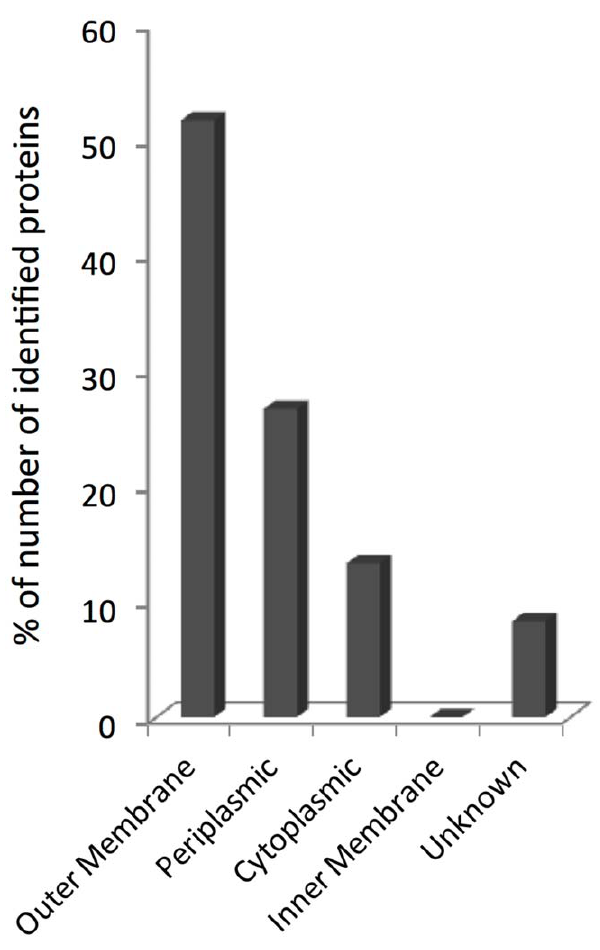
Figure 5. Shigellasonnei D tolR D galU GMMA proteome. The 61 GMMA-associated proteins that were identified are grouped into families based on their predicted cellular location, according to bioinformatic prediction by PSORTb v3.0 [34] and Lipo program [35]. The ‘outer membrane’ column comprises outer membrane proteins (identified by PSORTb) and lipoproteins predicted to be located in the outer membrane (identified by Lipo). No lipoproteins associated with the inner membrane were identified. The distribution shown is based on the number of identified proteins predicted to be located in a certain compartment. It does not reflect the protein amount. As analyzed by densitometry (Fig. 1D), the outer membrane fraction contains at least 69% of the total protein present in